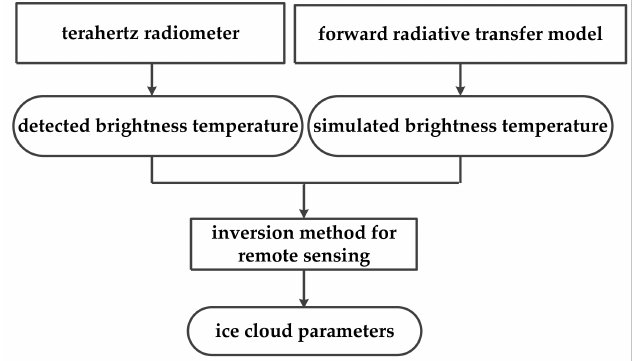
Figure 1. Process of the passive remote sensing of ice clouds at terahertz